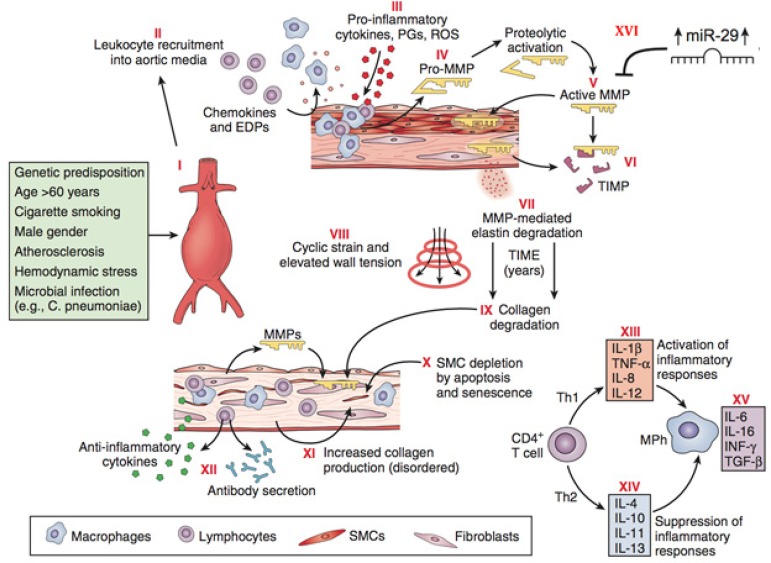
Pathophysiology of abdominal aortic aneurysms. Schematic diagram
illustrating events thought to contribute to the development and
progression of abdominal aortic aneurysms. Injury to the aortic
wall, either as a consequence of or in association with known risk
factors (I), leads to recruitment of leukocytes into the aortic
media (II), macrophage (MPh) activation, and production of
proinflammatory molecules (III). Macrophages also produce proenzyme
forms of matrix metalloproteinases (MMPs) (pro-MMPs) (IV), which are
activated in the extracellular space (V). Tissue inhibitors of
matrix metalloproteinases (TIMPs) may neutralize MMP activity (VI),
but this neutralization appears insufficient to prevent degradation
of structural matrix proteins (elastin and interstitial collagens)
(VII). Over a period of years, elastin degradation, cyclic strain,
and elevated wall tension bring about progressive aortic dilatation
(VIII). Collagen degradation further weakens the aortic wall (IX);
although medial smooth muscle cells (SMCs) and fibroblasts might
promote structural repair, apoptosis, and cellular senescence cause
SMC depletion (X), and interstitial collagen appears disorganized
(XI). Aneurysm tissues exhibit infiltration by T cells, B
lymphocytes, plasma cells, and dendritic cells and local deposition
of immunoglobulins, reflecting a cellular and humoral immune
response (XII). Understanding the adaptive cellular immune response
in abdominal aortic aneurysms may reveal how different T-cell
subsets (i.e., helper T cell type 1 [Th1] versus Th2) interact with
macro- phages to promote or suppress aneurysmal degeneration, on the
basis of the local balance of proinflammatory (XIII) and
anti-inflammatory (XIV) molecules. Some cytokines produced within
aneurysm tissue, such as interleukin-6 (IL-6) and
interferon-γ (IFN-γ), may have dual and opposing
functions depending on the specific context (XV). The promotion of
miR-29 induces the extracellular matrix degradation and induces the
formation of aneurysms (XVI). EDPs, Elastin degradation peptides;
PGs, prostaglandins; ROS, reactive oxygen species; TGF-β,
transforming growth factor-β; TNF-α, tumor necrosis
factor-α; miR-29, microRNA-29[70].